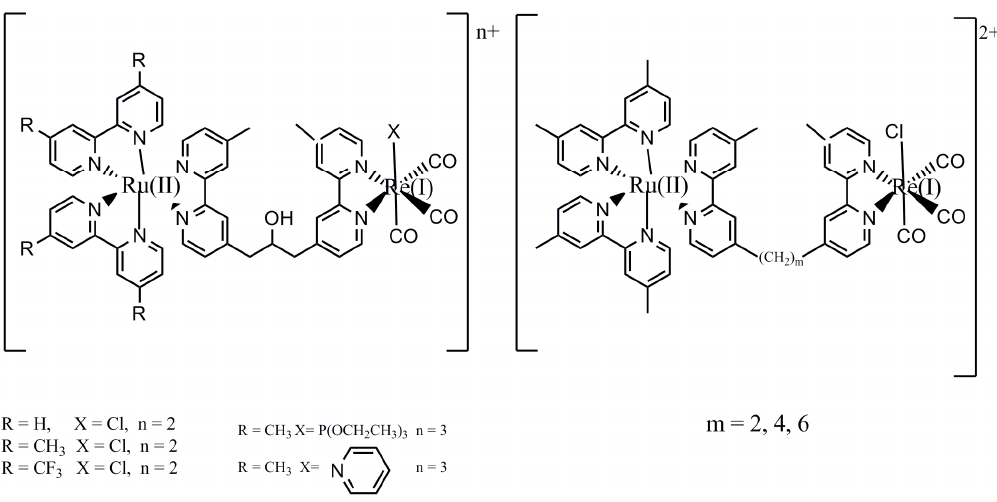
Figure 23. Some examples of binuclear complexes of Re(I) and Ru(II) acting as molecular photocatalysts in the process of photoactivated CO 2 reduction ([169,183] and references therein).